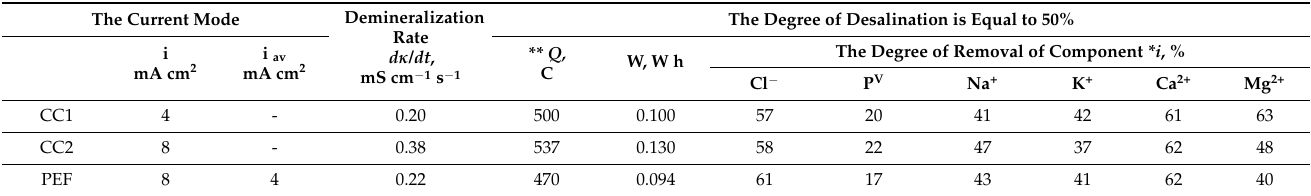
Figure 8. Dependences of the conductivity of the desalinated multicomponent solution ( a ), the potential drop on the MA-41P membrane and adjacent depleted and enriched solution layers ( b ), as well as the pH values of the solution at the outlet of the desalination compartment ( c ) upon the duration of the electrodialysis in the CC1 (Curve 1), CC2 (Curve 2), and PEF (Curve 3) modes. Table 6. Select characteristics of a multicomponent solution ED desalination.